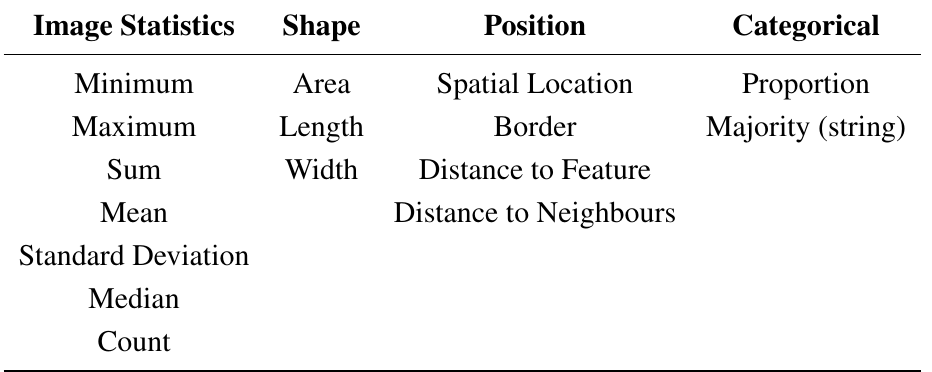
Table 1. Available attributes for each object within the Remote Sensing and GIS Library (RSGISLib) (Version